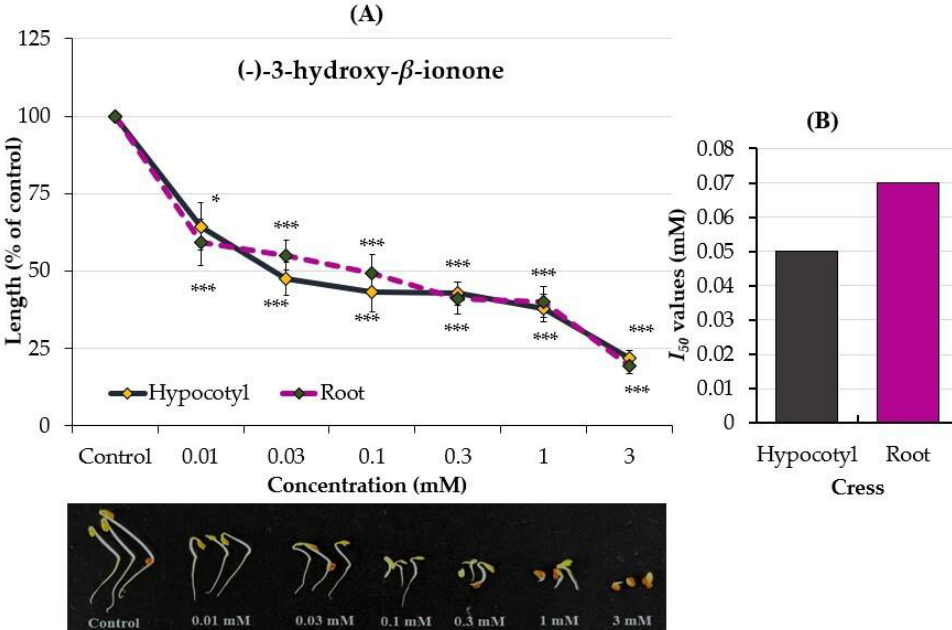
Figure 4. ( A ) Effects of (−) -3-hydroxy- β -ionone on the seedling growth of cress ( Lepidium sativum) and ( B ) I 50 values. The means ± SE from three replications with 10 seedlings per replication (n = 30) for each determination are shown. *, and *** represent statistically significant differences between the control and the treatment: p < 0.05, p < 0.001 ( post hoc Tukey’s test) .